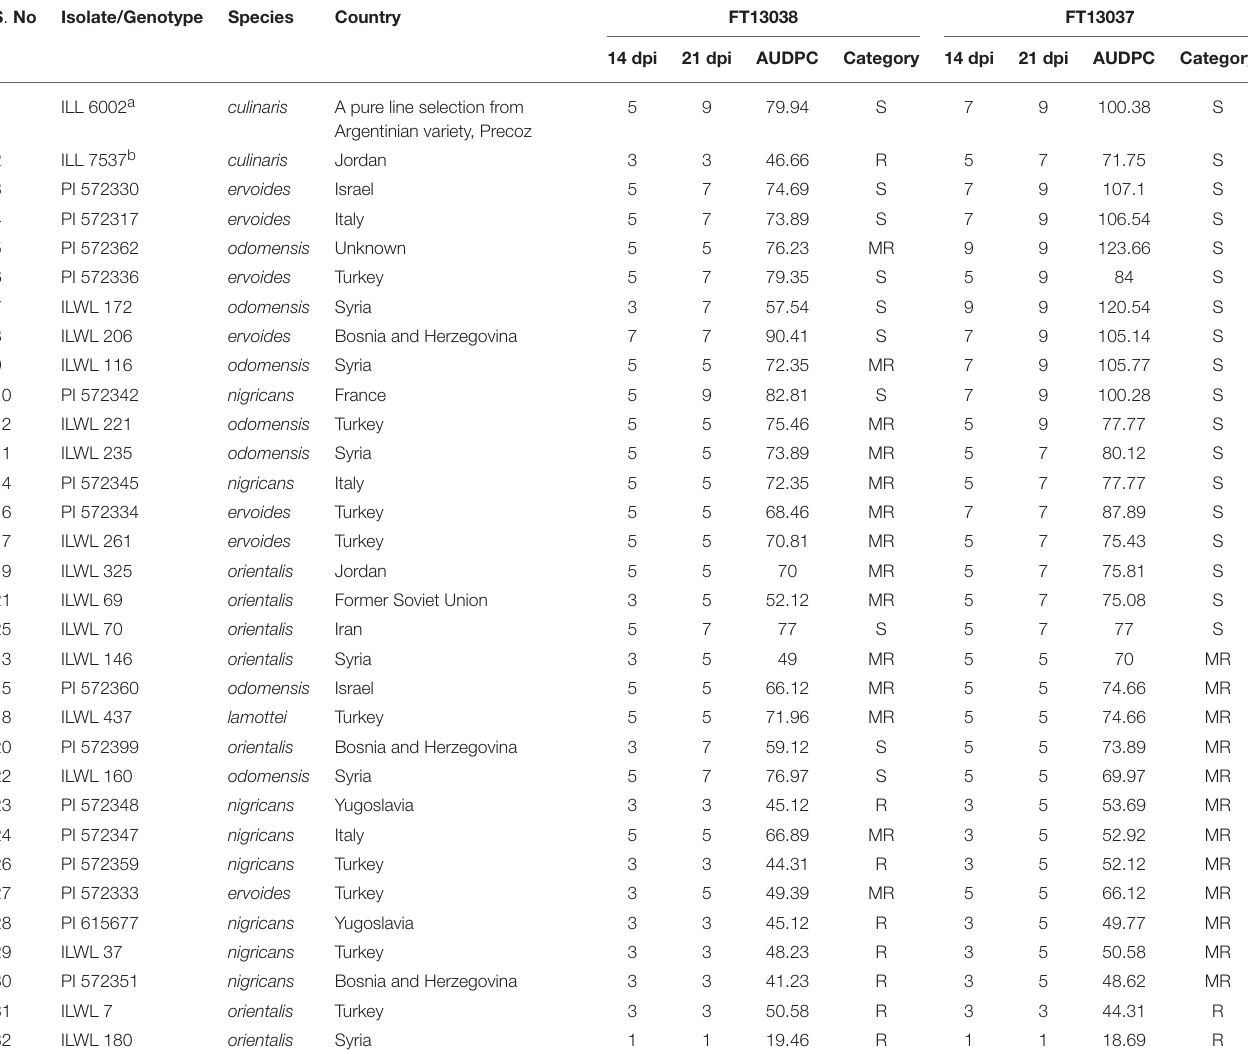
TABLE 3 | Details of the genotypes used in the study along with corresponding modal disease scores at 14 and 21 DPI and AUDPC. S . No Isolate/Genotype